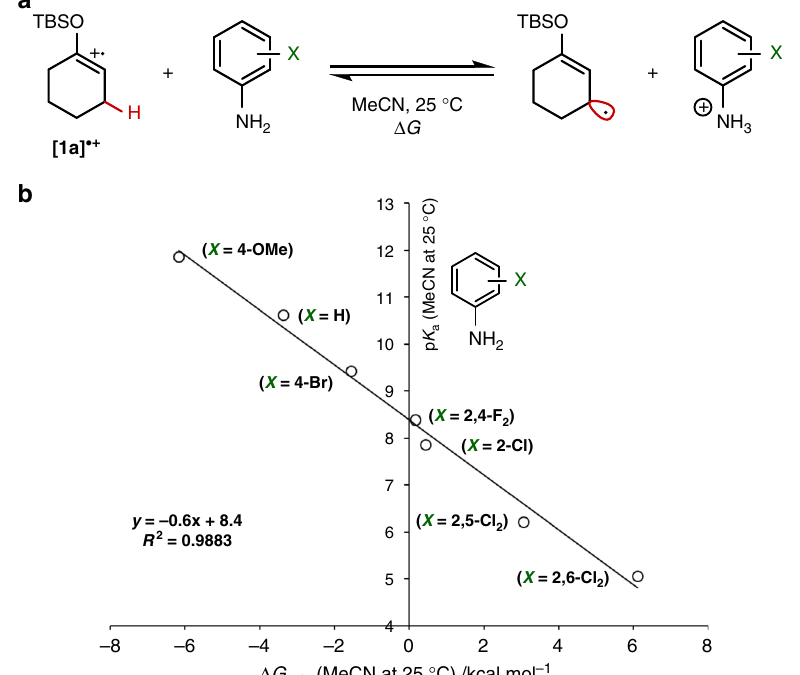
Fig. 2 Estimation of p K a of radical cation [ 1a ] (cid:129) + . a Acid – base equilibria between [ 1a ] (cid:129) + and substituted anilines. b Linear free energy plot for the acid – base equilibria